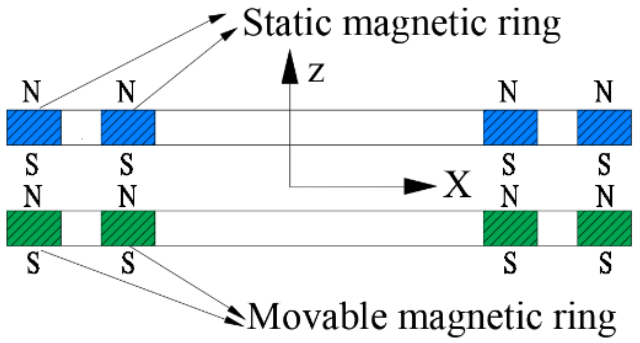
Figure 5. Structure composition of the permanent magnet bearing. The material of the permanent magnetic bearing was the permanent, magnetic, rare earth material NdFeB35, which adopted an axial magnetization. The specific parameters of the permanent magnetic bearing are shown in Table 2. Table 2. Material parameters of the permanent magnet